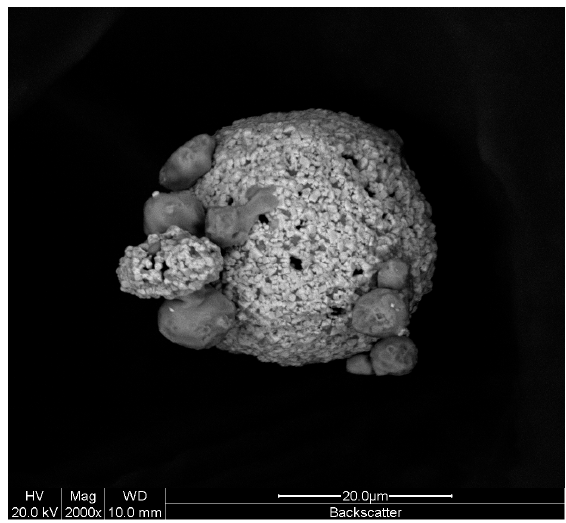
Figure 6. SEM backscatter image of decorated 18Ni-10Co-72WC at 2000×.